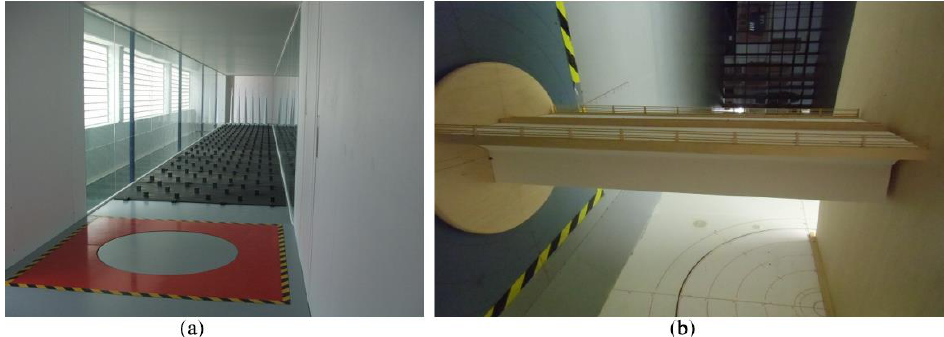
Figure 3. Configurations of the wind tunnel: ( a ) Cross section of the wind tunnel; ( b ) Bridge model on the rotational plate [42].